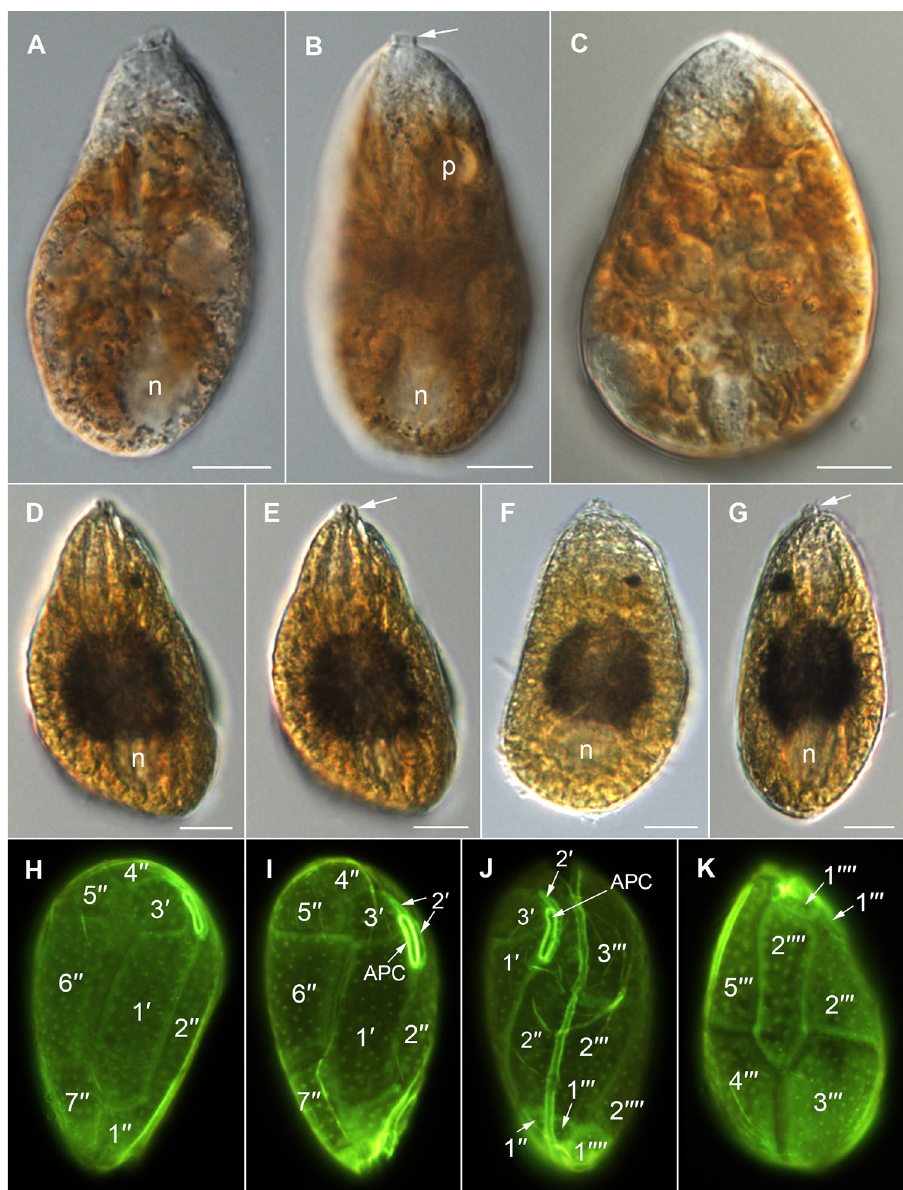
Figure 2. Light micrographs of Ostreopsis tairoto sp. nov. strain O1C6 showing the cell shape and general features, including stained thecal plates visualized by epifluorescence. ( A – C ) Living cells. ( D – G ) Lugol fixed cells. ( H – K ) Solophenyl Flavine stained cells viewed by epifluorescence microscopy. ( A ) Mid cell focus, note the dorsal nucleus (n). ( B ) Cell focussed on the ventral opening (arrow) with visible pusule (p) and dorsal nucleus (n). ( C ) Example for a wider ovoid cell. ( D,E ) Same cell in different focal planes. ( D ) Mid cell focus, note the dorsal nucleus (n). ( E ) Cell focussed on the ventral opening (arrow). ( F ) Wider ovoid cell. ( G ) Narrower elongated cell. Note the dorsal nucleus (n) and the ventral opening (arrow). ( H ) Apical view. ( I ) Apical to left lateral view. ( J ) Left lateral view showing the slightly undulating cingulum path. ( K ) Antapical view. Scale bars = 10